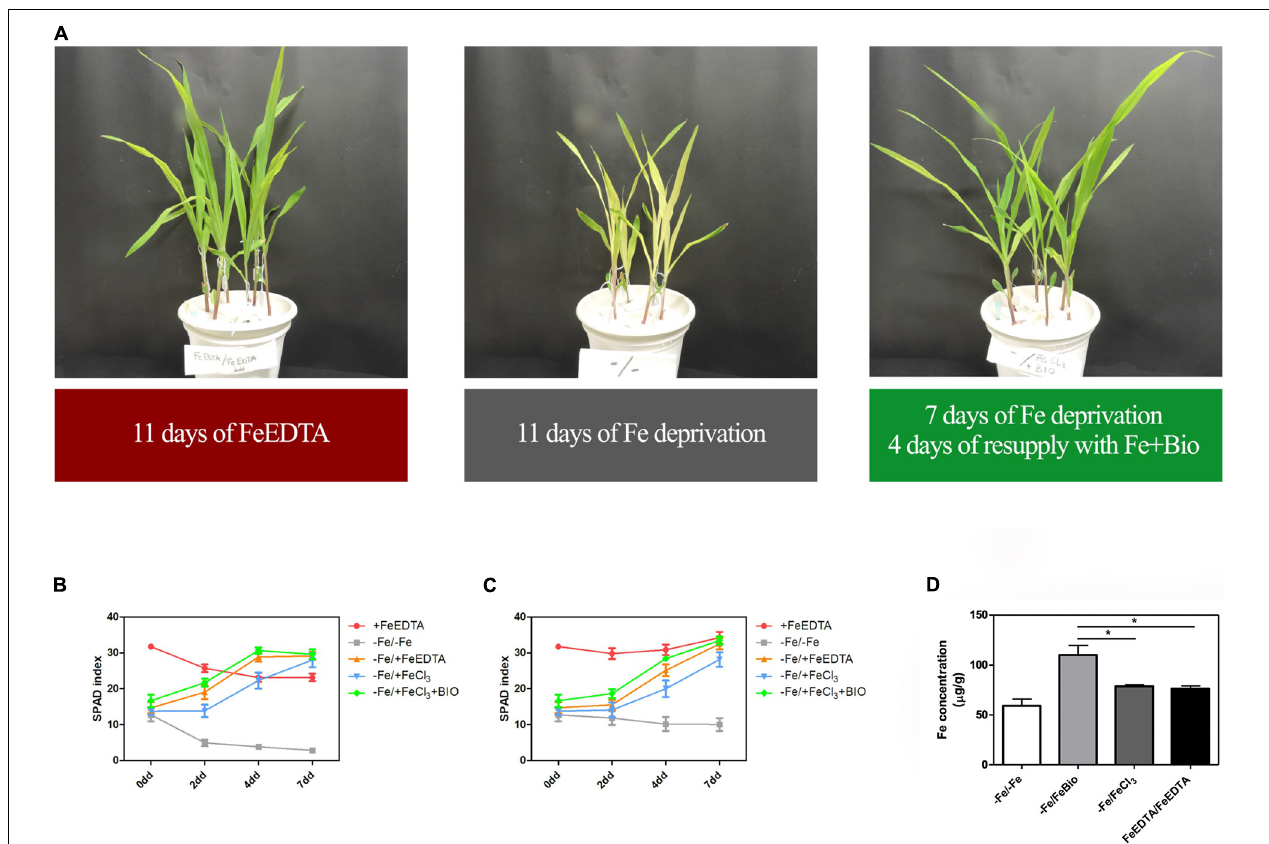
FIGURE 4 | Effects of PH on recovery from Fe deprivation. Maize plantlets grown in nutrient solutions with FeEDTA for 11 days, without any Fe source for 11 days, or without Fe for 7 days and then supplied with FeCl 3 mixed with the biostimulant for further 4 days (A) . SPAD values progression in leaves of maize seedlings treated with the PH (Bio) during recovery from Fe deprivation. Maize plantlets were grown in a nutrient solution containing FeEDTA 20 µ M for 14 days (+ FeEDTA), or in an Fe-depleted nutrient solution (-Fe) for 7 days, and supplied with 20 µ M Fe as either FeEDTA (–Fe/ + FeEDTA), FeCl 3 (–Fe/ + FeCl 3 ) or FeCl 3 supplemented with 0.1 mL L − 1 PH (–Fe/ + FeBio). A group of plants were maintained in the nutrient solution deprived of Fe with the addition of 14.3 mg L − 1 of N supplied as inorganic nitrogen (–Fe/–Fe). SPAD values were taken at the top (B) and mid (C) part of the leaf. Mean values are reported. Bars represent the standard error (SEM) ( n ≥ 9). Fe concentration in maize leaves subjected to different treatments during recovery from Fe deprivation (D) . Values of Fe concentration assessed via ICP-MS in maize leaves harvested after 7 days of Fe supply. Mean values are reported. Bars represent the standard error (SEM) ( n = 3), Student’s t -test was applied, * p < 0.05.